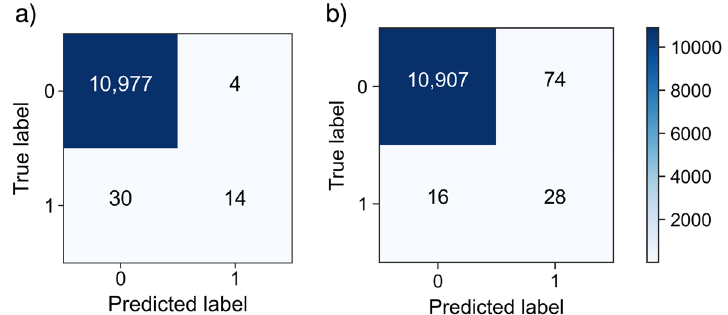
We show how our model performs in terms of identifying anomalies—edges that have been injected in the dataset—as we vary the prior on Z , tuned by the parameter µ . Here π = 0.25 and ρ a = 0.087